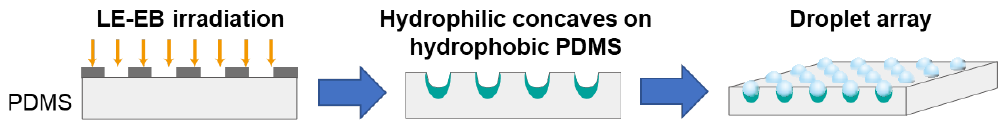
Figure 8. Proposed single-step fabrication method for obtaining hydrophilic concave patterns on hydrophobic polydimethylsiloxane (PDMS).